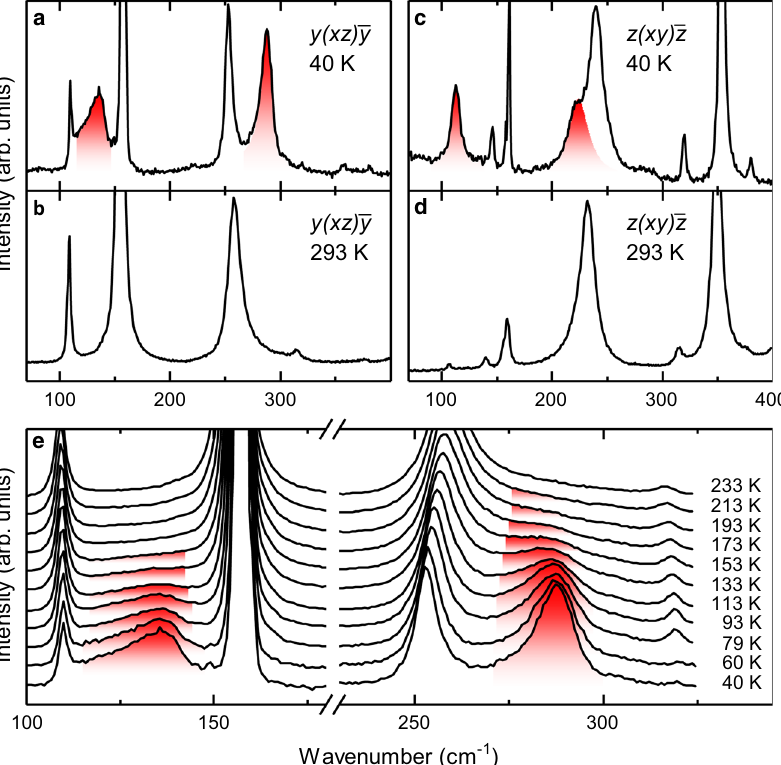
Fig. 4 Emerging of new phonon modes. Raman spectra for y(xz)y ̅ , a and b , and z(xy)z ̅ , c and d , con fi gurations at 40 and 293 K, respectively. e Temperature dependent Raman spectra in y(xz)y ̅ con fi guration. The colored areas indicate new Raman-active